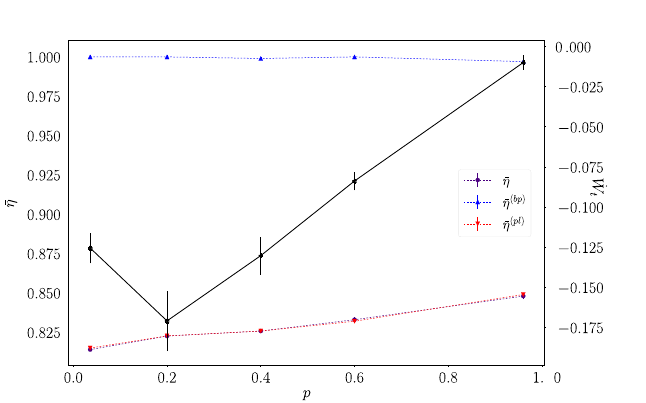
Figure 11. Estimation of the large deviation function. Behavior of the function − ln ( P (η t ))/ t in Eq. (11) computed at p = 0.2 and M l = 1.0 , using several time window sizes.